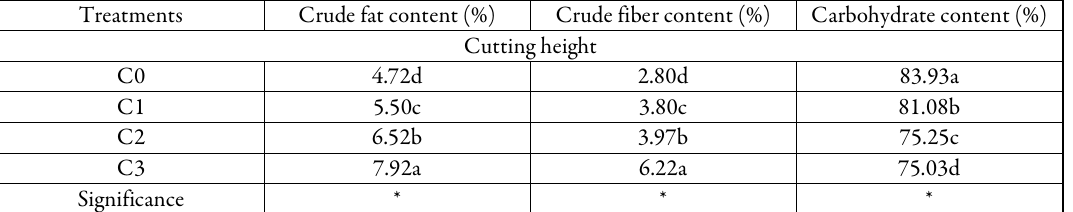
Table 7. Effect of cutting heights and fertilizer application on fat, crude fibre and carbohydrate content of Amaranthus cruentus L.